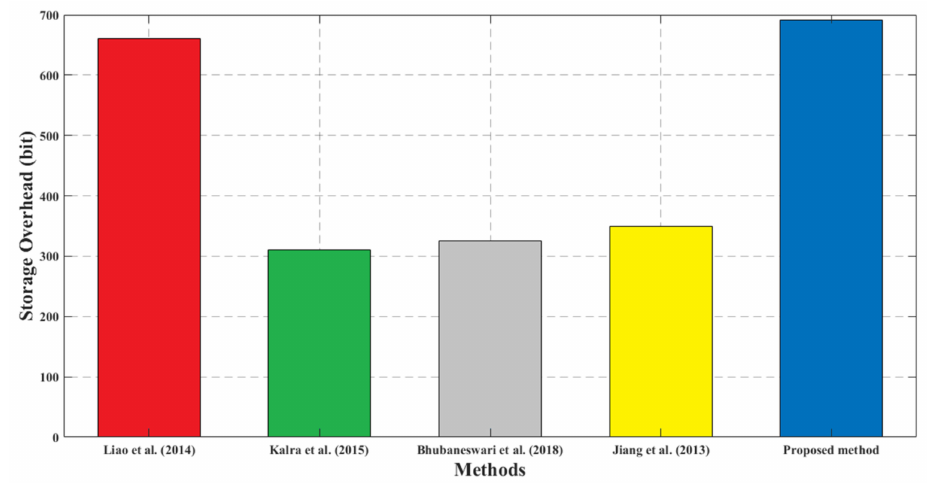
Figure 5. Storage